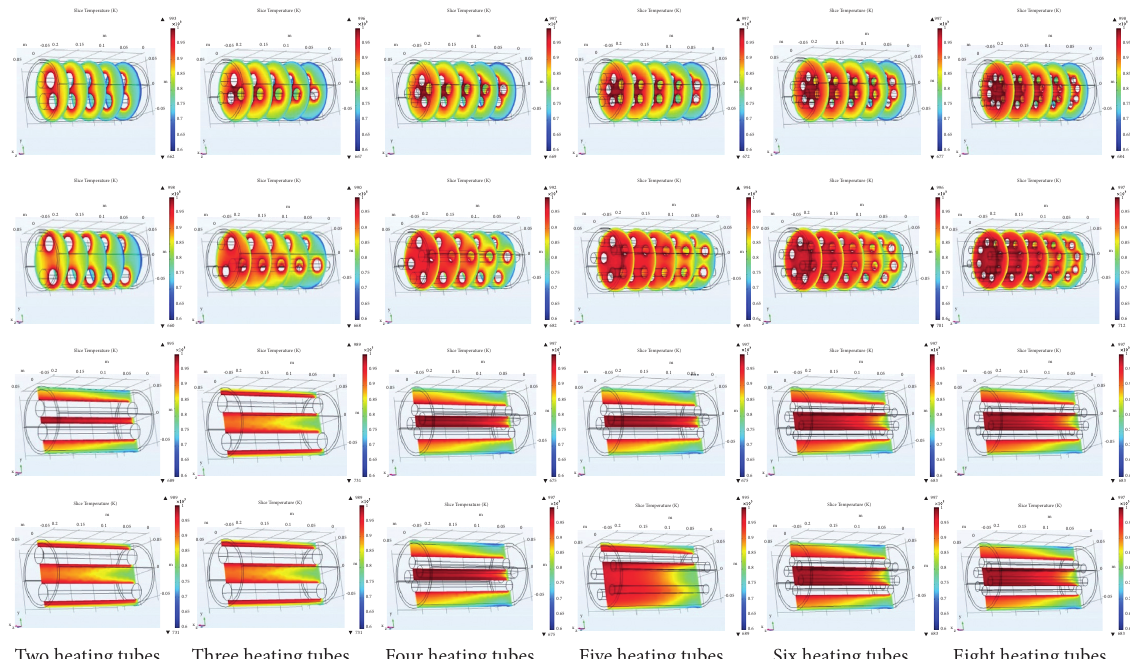
Figure 4: Temperature distributions (sliced perpendicular (first and second line) and parallel (third and fourth line) to the axis) according to the number of heating tubes for geometry 1: the cases in which the distance between the heating tubes is closest (first and third line) and farthest (second and fourth